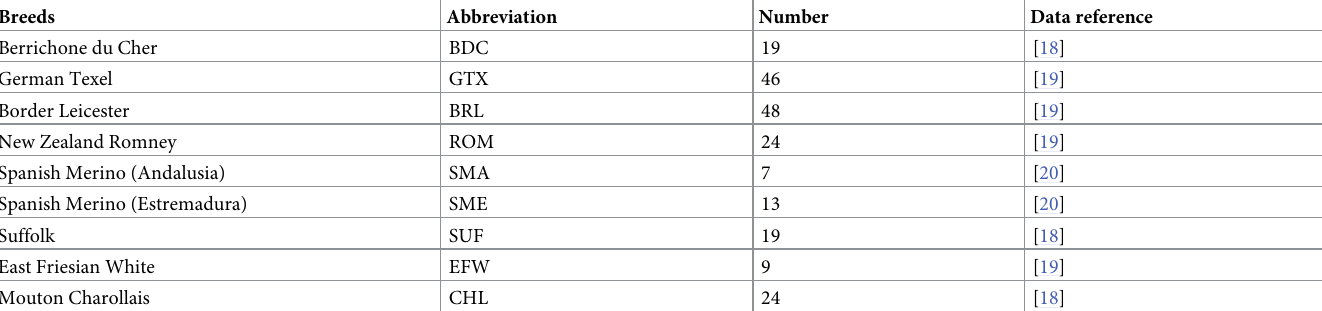
Table 1. Description and source of publicly available genotype data on 209 individuals across nine sheep